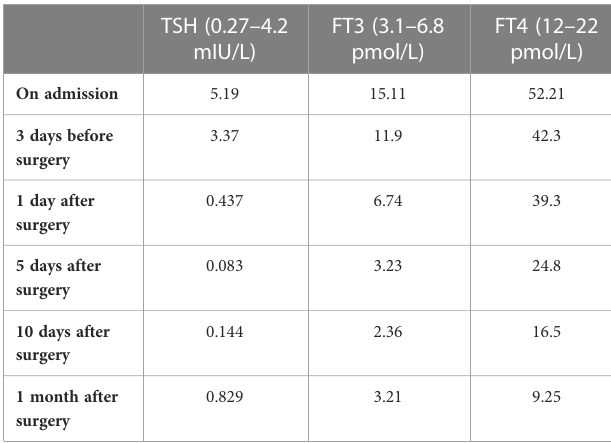
TABLE 1 Serum levels of TSH and thyroid